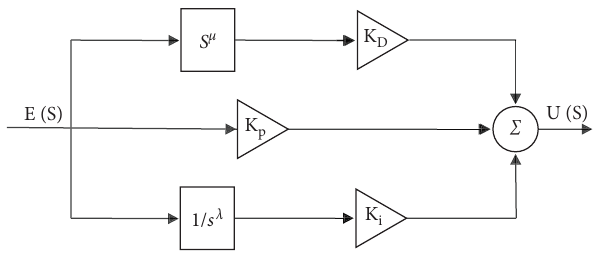
Figure 3: Proposed structure of FOPID